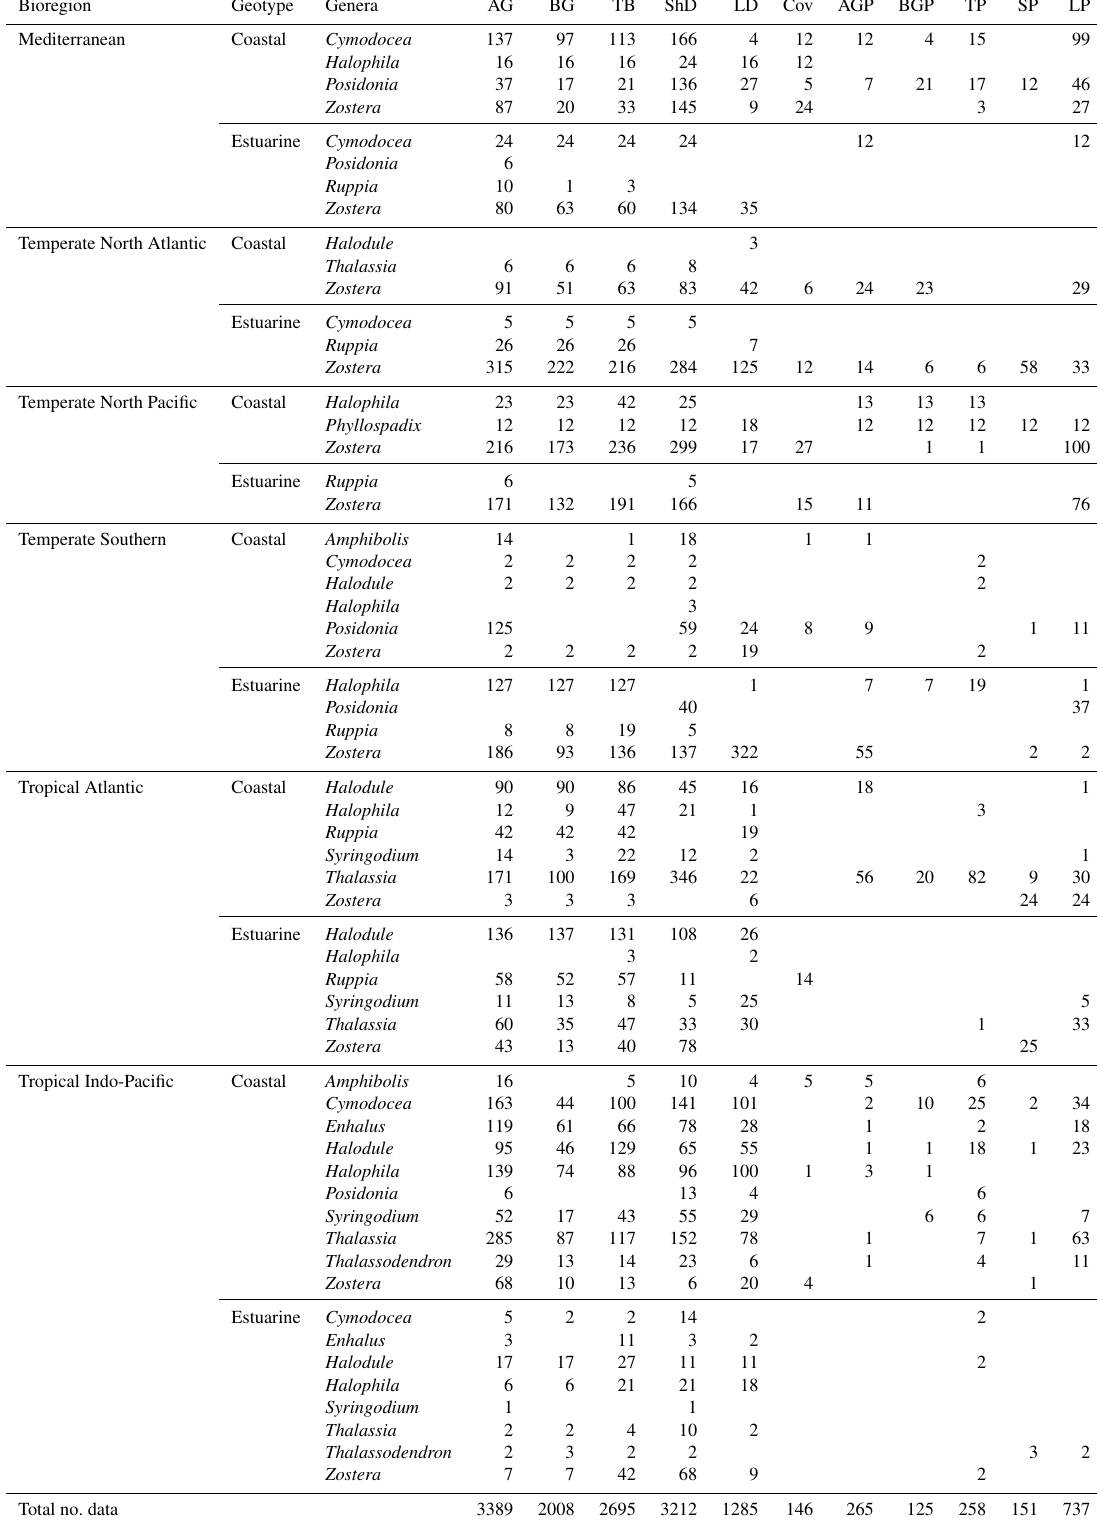
Table 1. Summary table outlining the count of data for each of the 15 seagrass variables based on bioregion, geotype and genera cate- gorical variables. Above-ground biomass (AG), below-ground biomass (BG), total biomass (TB), shoot density (ShD), leaf density (LD), percent cover (Cov), above-ground production (AGP), below-ground production (BGP), total production (TP), shoot production (SP) and leaf production